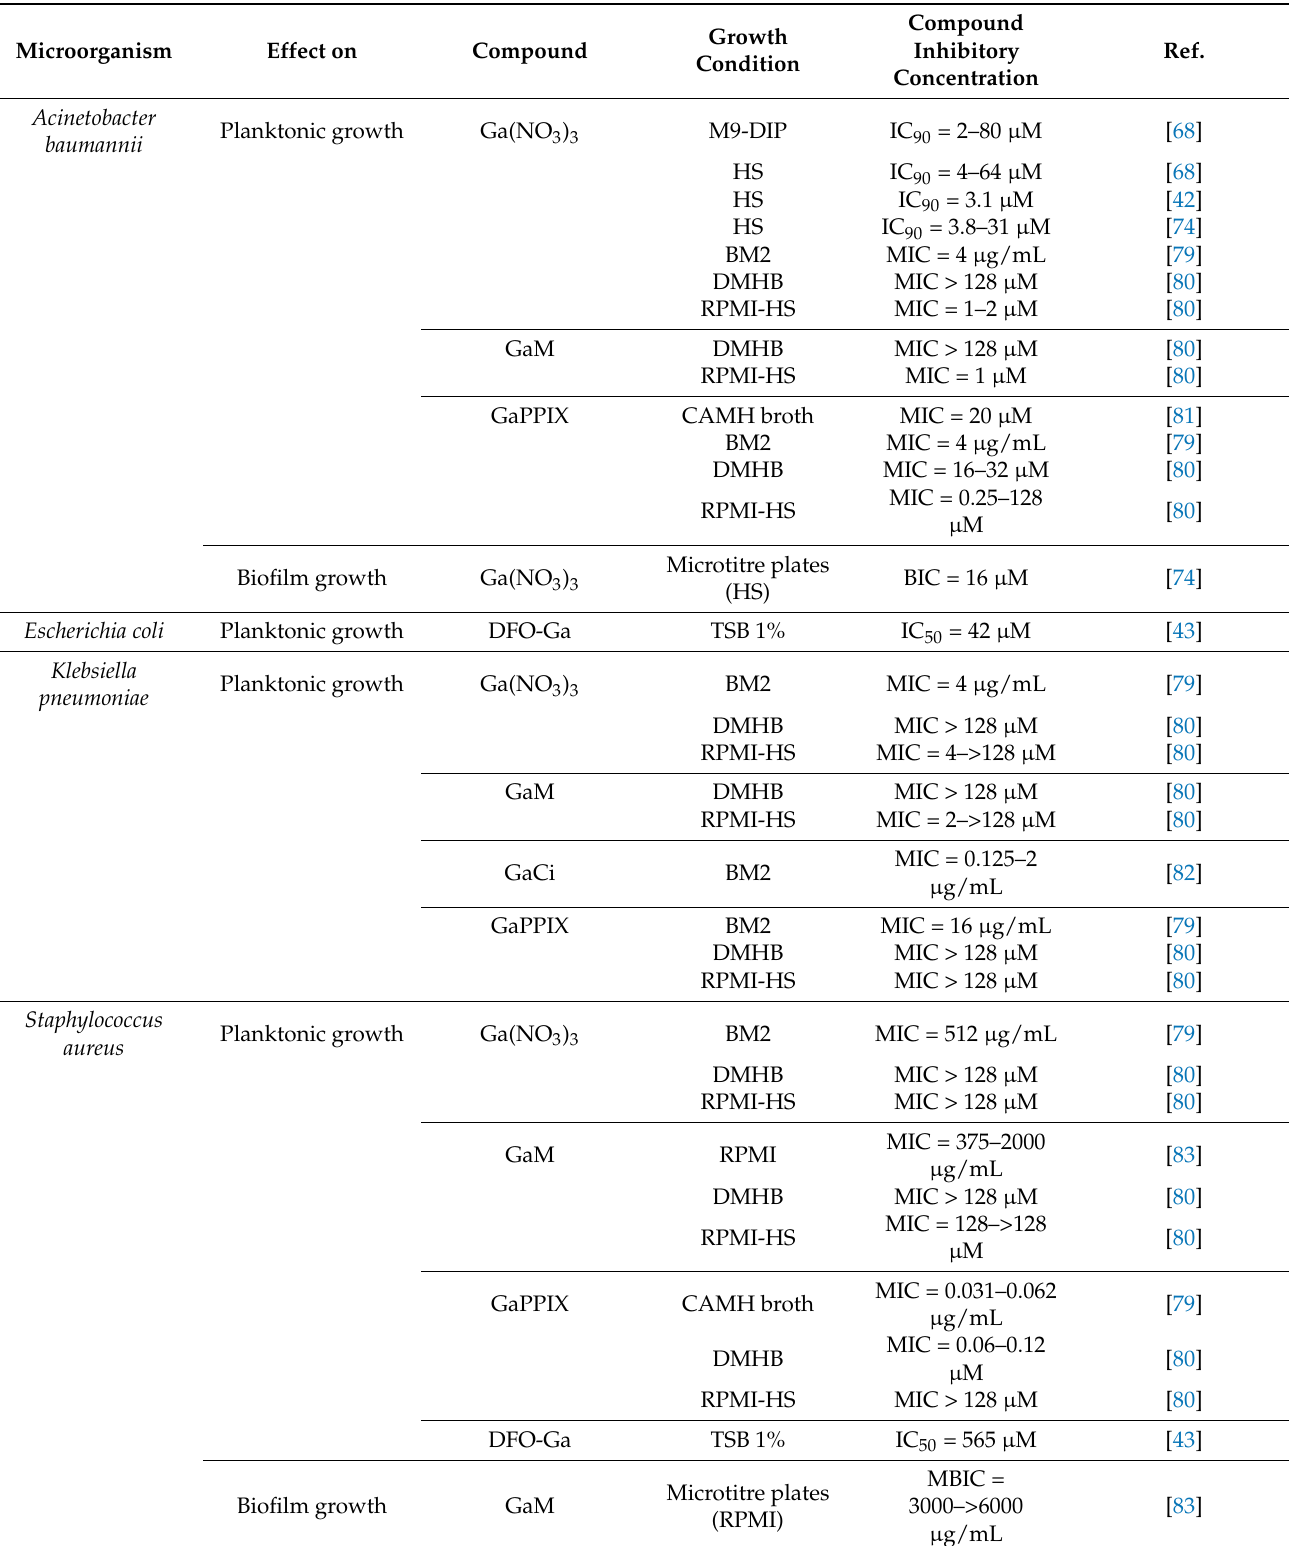
Table 2. In-vitro antimicrobial activity of Gallium